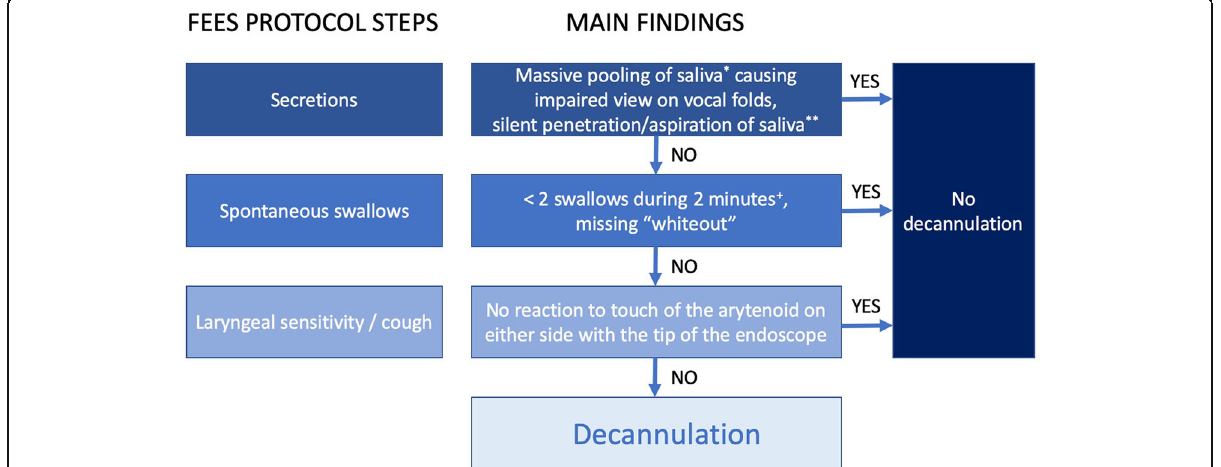
Fig. 1 Stepwise evaluation of swallowing function according to the “ Standardized endoscopic Swallowing Evaluation for tracheostomy decannulation in critically ill neurologic patients ” ; * not only coating; ** permanently without any reaction; + if exactly two swallows occur in this time period, another 2 minutes of observation are recommended (with permission from [18]: Warnecke T, Muhle P, Claus I, Schröder JB, Labeit B, Lapa S, Suntrup-Krueger S, Dziewas R. Neurol. Res. Pract. 2,9